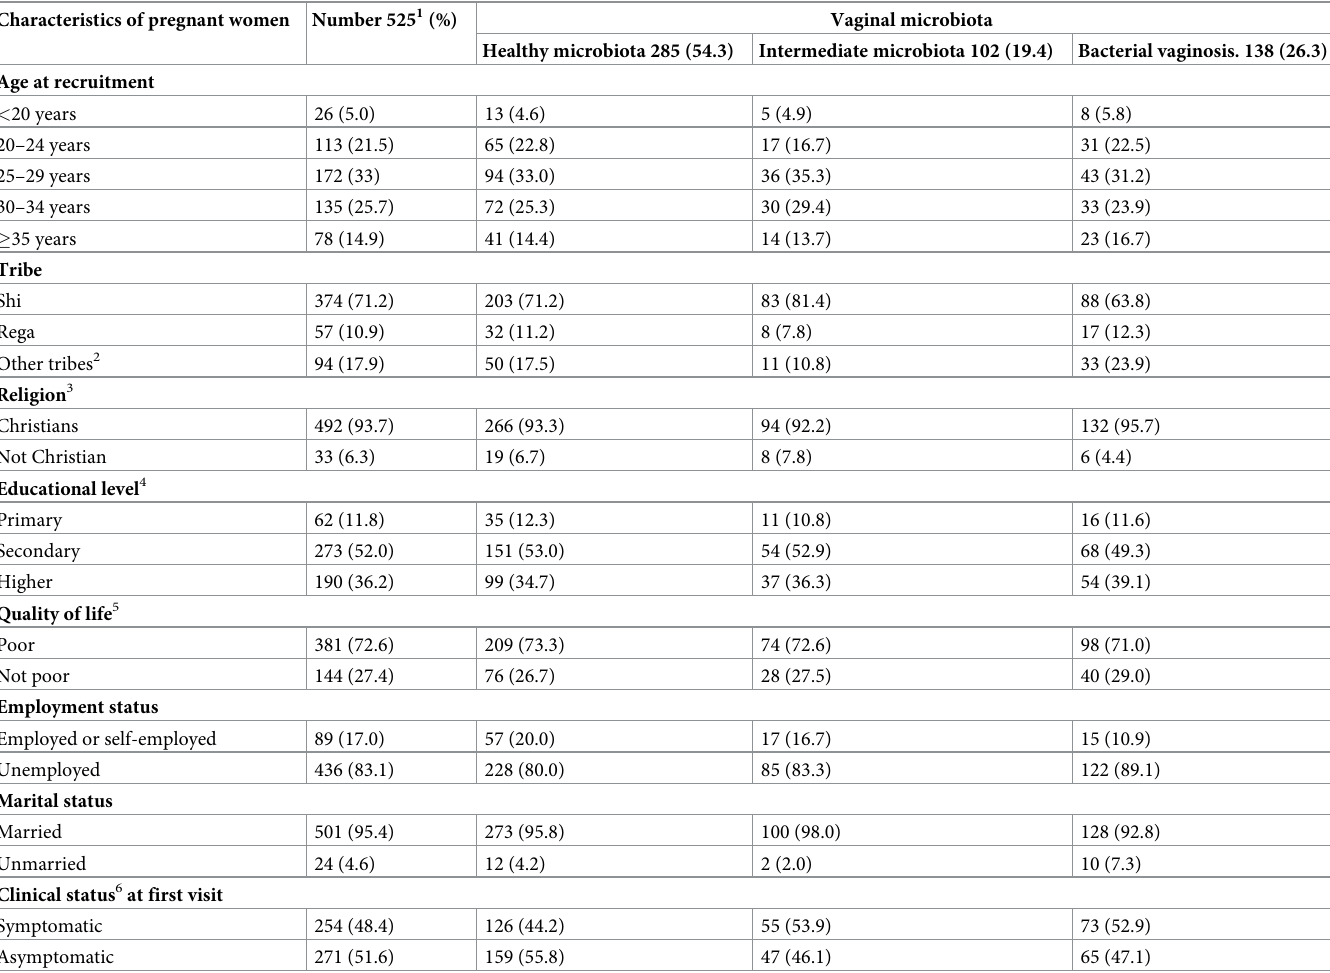
Table 1. Sociodemographic characteristics and pregnancy outcomes of the study population stratified by vaginal microbiota categorization. Characteristics of pregnant women Number 525 1